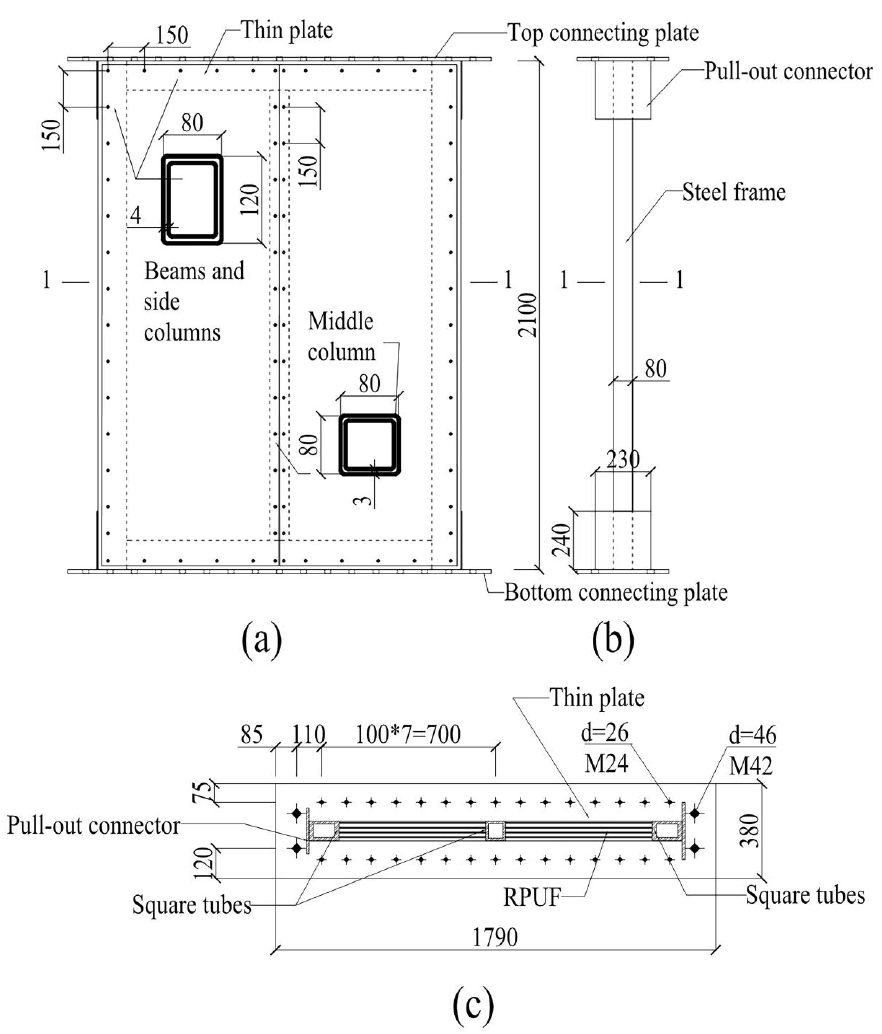
Figure 1. Schematic diagram of the specimen: ( a ) front view, ( b ) side view, ( c ) 1–1 section view. Table 1. Compositions of the